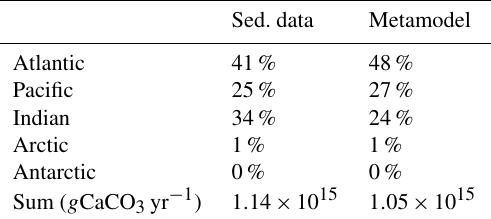
Table 1. Estimates of the modern global deep-sea CaCO 3 burial flux. The fractional contribution of each basin is shown, in percent, and the total estimated burial flux shown in g CaCO 3 yr − 1 . The two columns correspond to the two estimates shown in Fig. 2, and the basin areas correspond to province map 1 shown in Fig.